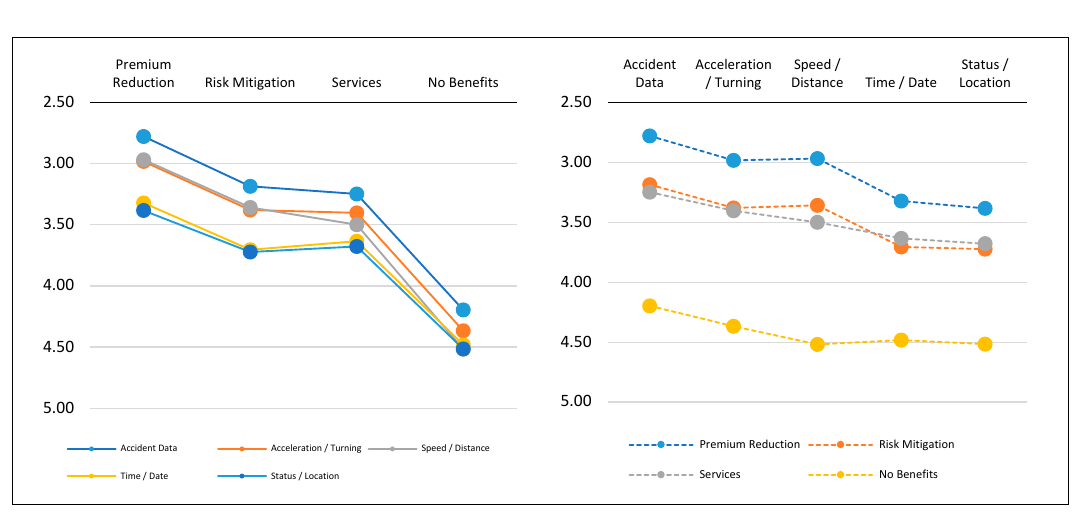
Figure 3. Willingness to share by type of benefit and type of information.